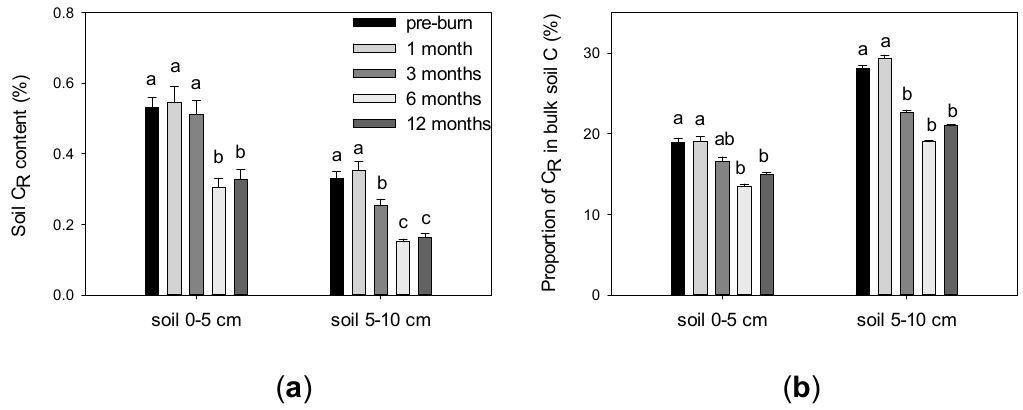
Figure 4. Oxidation resistant soil C (C R ) content of soils from depths of 0–5 and 5–10 cm ( a ) and the proportion of C R in bulk soil C ( b ). Within each group, means with the same letter do not differ at p < 0.05 and error bars represent the standard error of the mean.